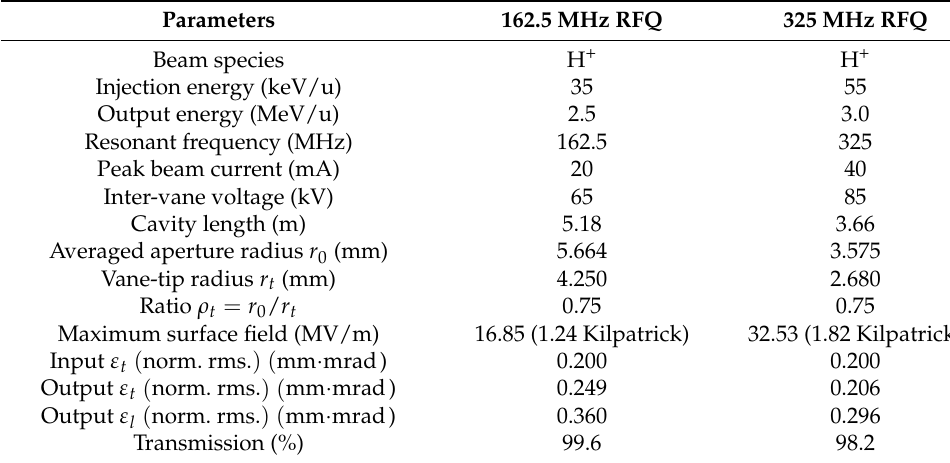
Table 1. Design parameters of the proton